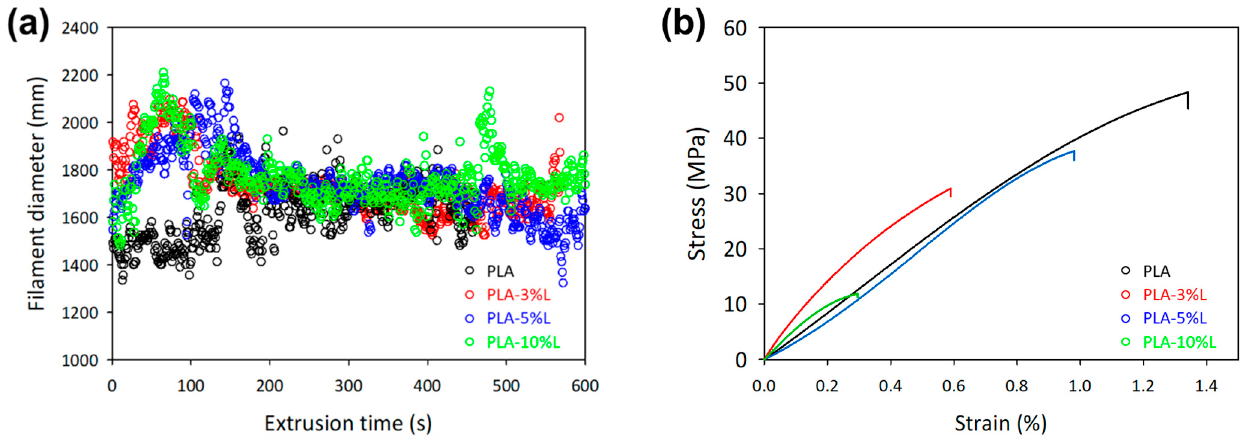
Figure 3. The effect of lignin composition on the stability of filament extrusion at ( a ) filament diameter and ( b ) mechanical strength.